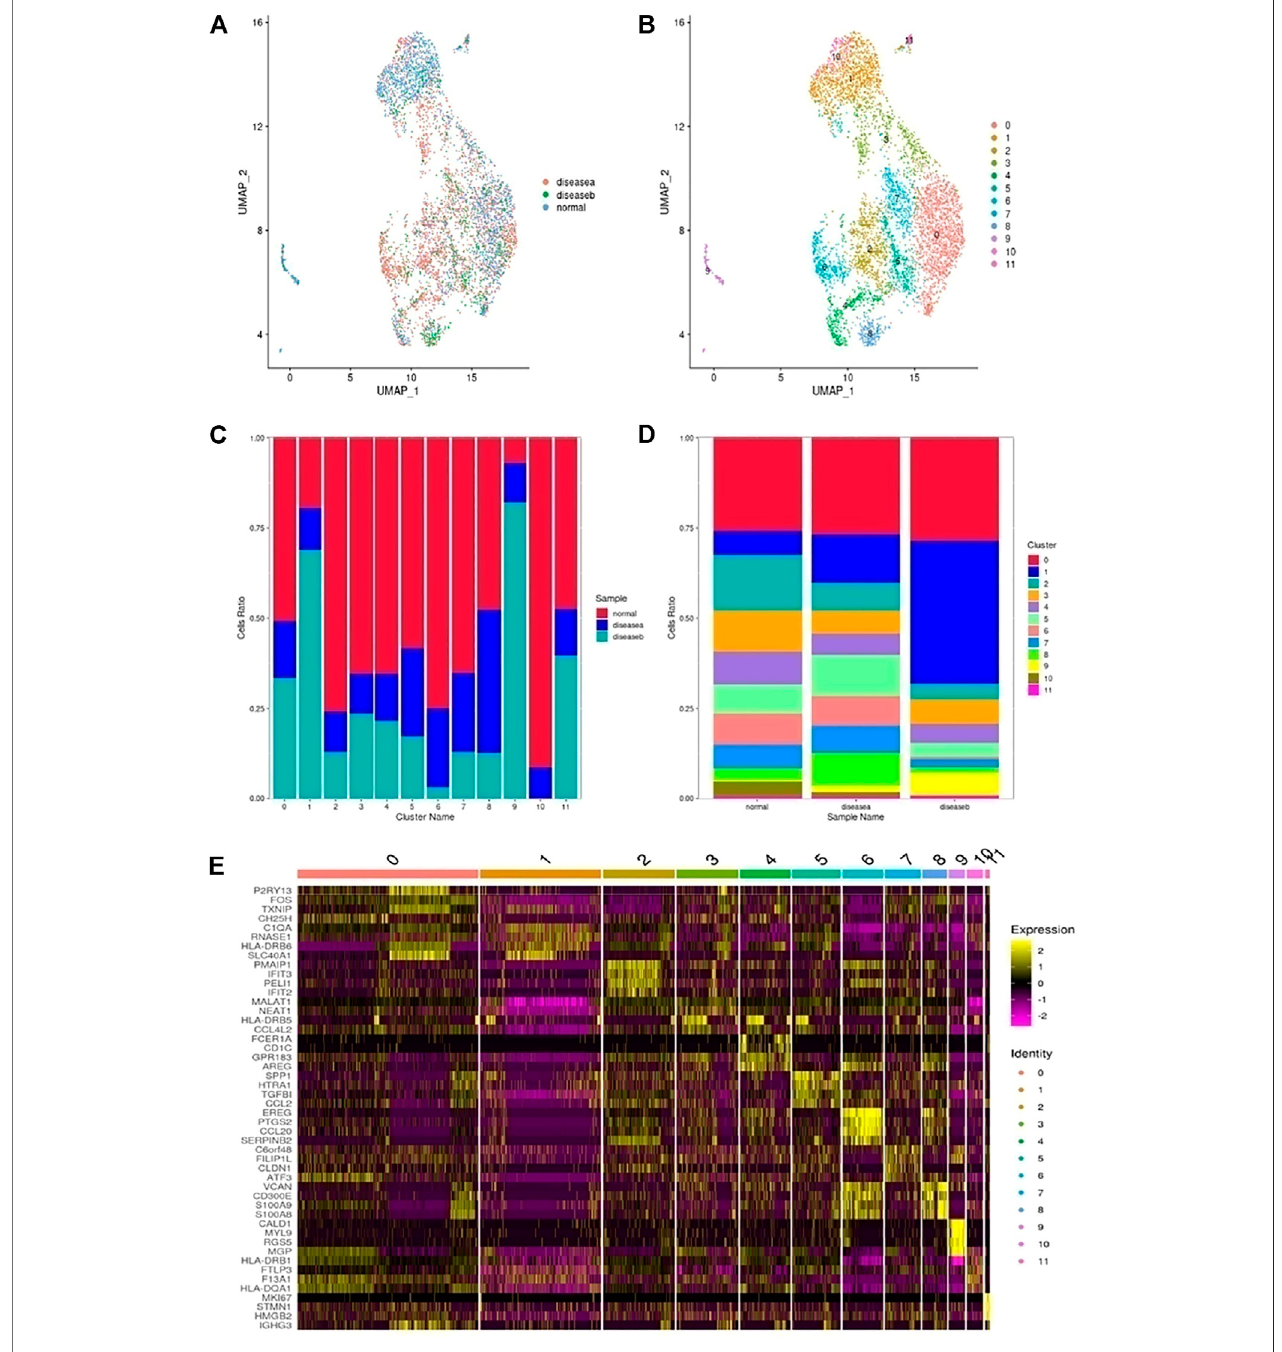
FIGURE 5 | Heterogeneity of monocytes and macrophages in human ascending thoracic aortic walls. (A) UMAP plot of monocyte and macrophage cells colored accordingtoidenti fi edclusters. (B) Monocytesandmacrophageswerefurtherdividedinto12subclusters(C0~11)asshowninthecolor-codedUMAPplot. (C) Theplot shows the proportion of cells in each sample. (D) The plot shows the composition of cell subclusters. (E) The heatmap shows the top fi ve genes and their relative expression in each subcluster of monocytes and macrophages. A: disease a, B: disease b, N: normal.